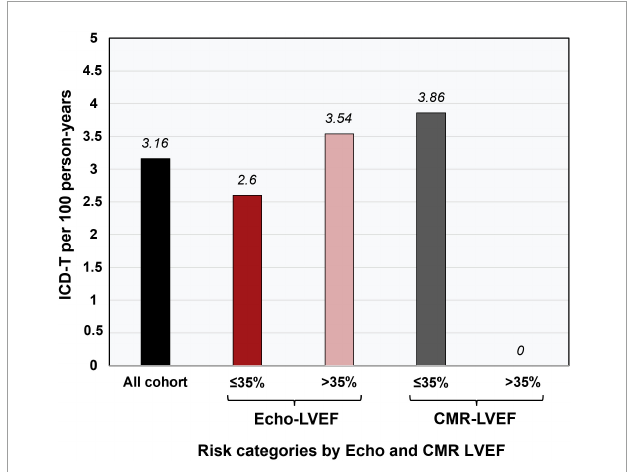
FIGURE2 ICD-T per 100 person-years across Echo and CMR LVEF categories before ICD implantation. CMR, cardiac magnetic resonance; Echo, echocardiography; ICD, implantable cardioverter-defibrillator; ICD-T, appropriate implantable cardioverter-defibrillator therapies; LVEF, left ventricular ejection